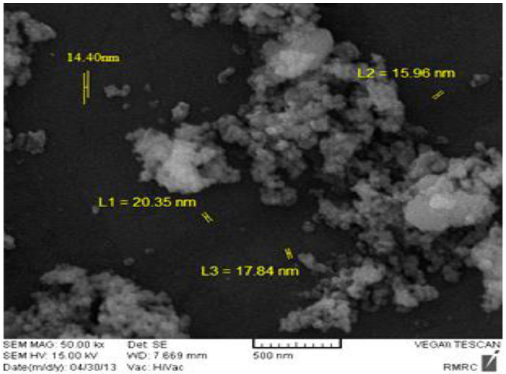
Fig. 3. M-H curves of CuO- NiO Nano composite (up trian- gle): A sample and (circle): B sample after calcination.